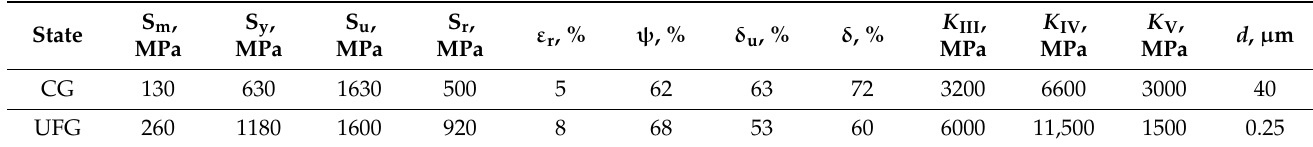
Table 2. Mechanical characteristics of Ti 49.4 Ni 50.6 alloy in the CG and UFG states after tensile tests at